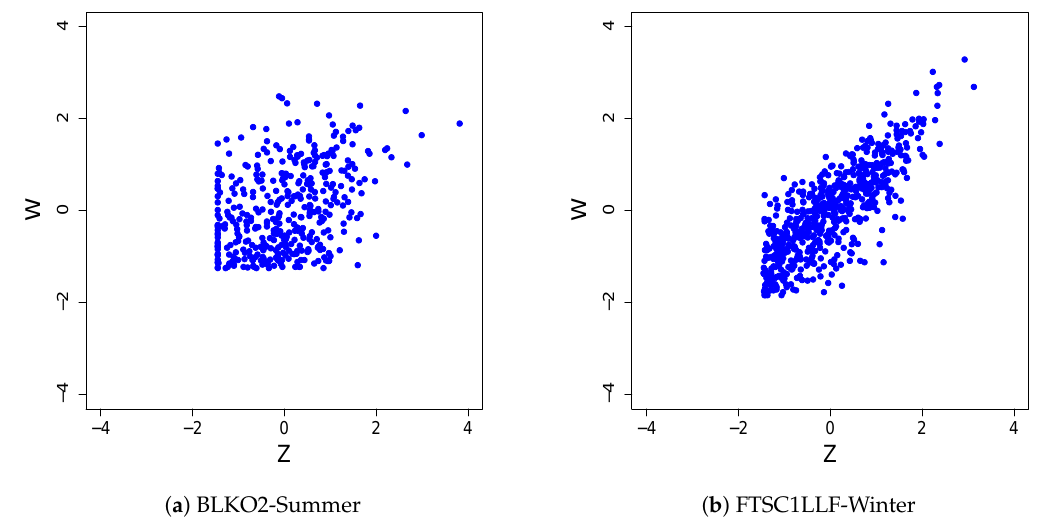
Figure 1. Scatter plots of the transformed forecast and